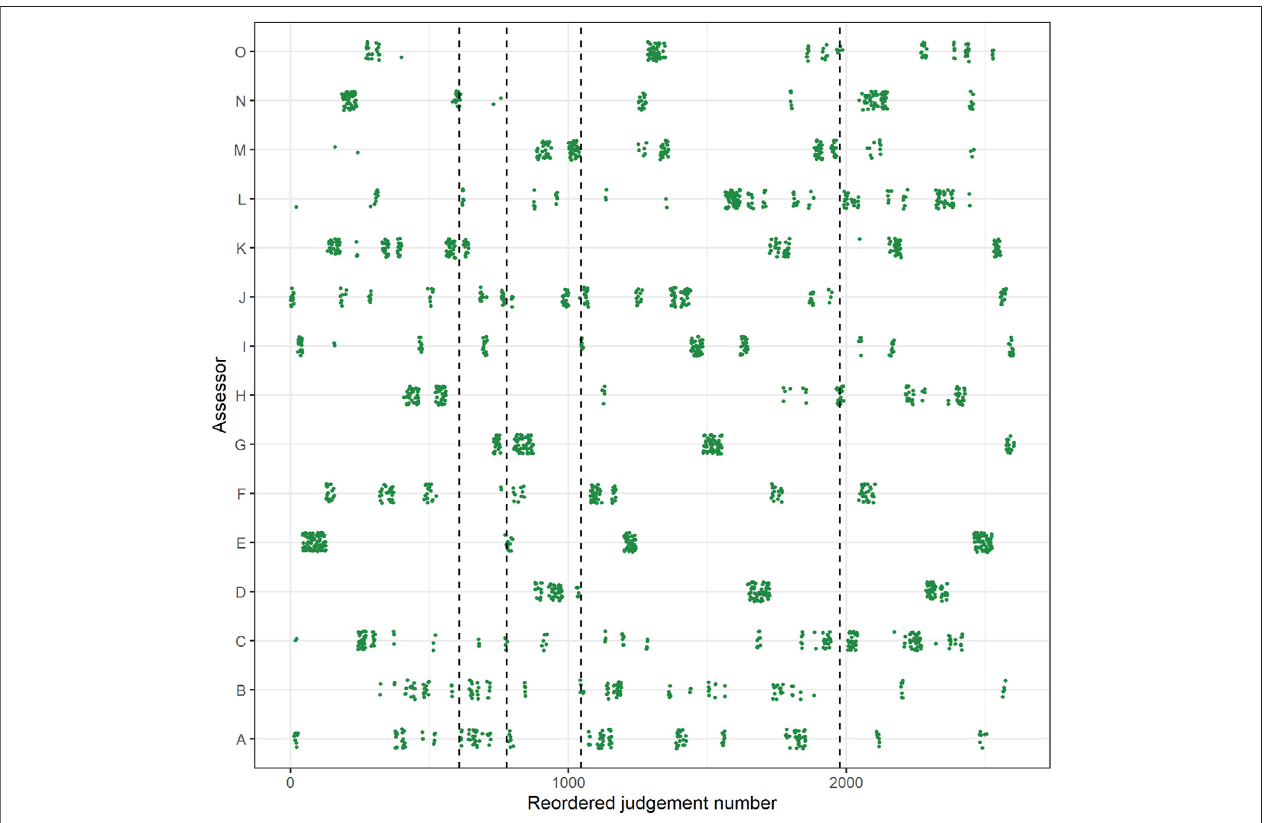
FIGURE 2 | Distribution of judgments throughout the assessment in phase 1 (Judgment number; x-axis) by assessor (y-axis), after reordering. The vertical dotted linesindicatethejudgementnumberatwhichtheestimatesreachedarank-orderreliabilityof0.50,0.70,0.80,and90(respectivelyfromlefttoright).Note:jitteraddedto y-axis coordinates for